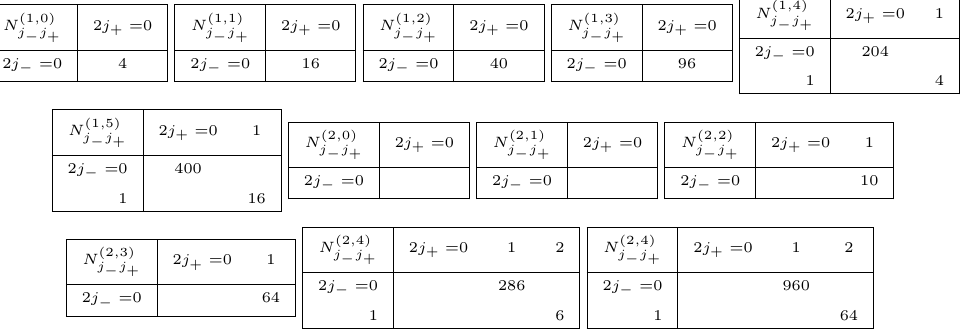
Table 14 . Re(cid:12)ned BPS invariants N ( b;d )